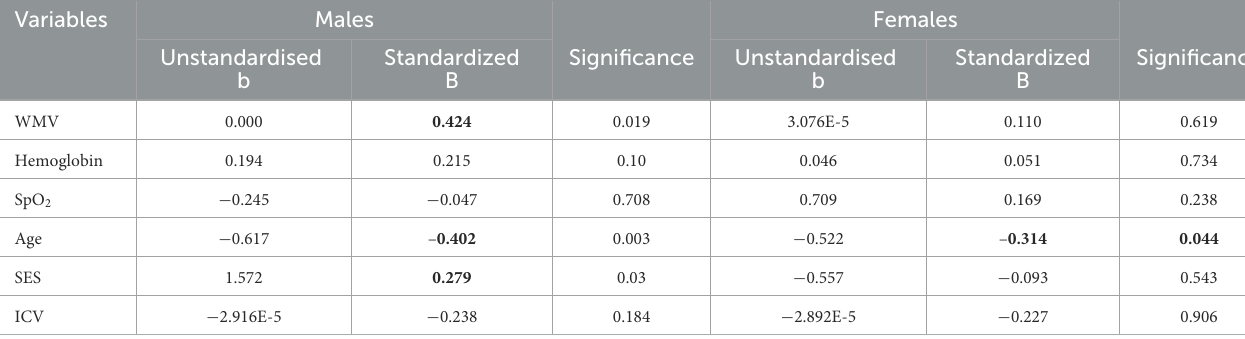
TABLE 6 Regression coefficients for processing speed index in male and female patients. Variables